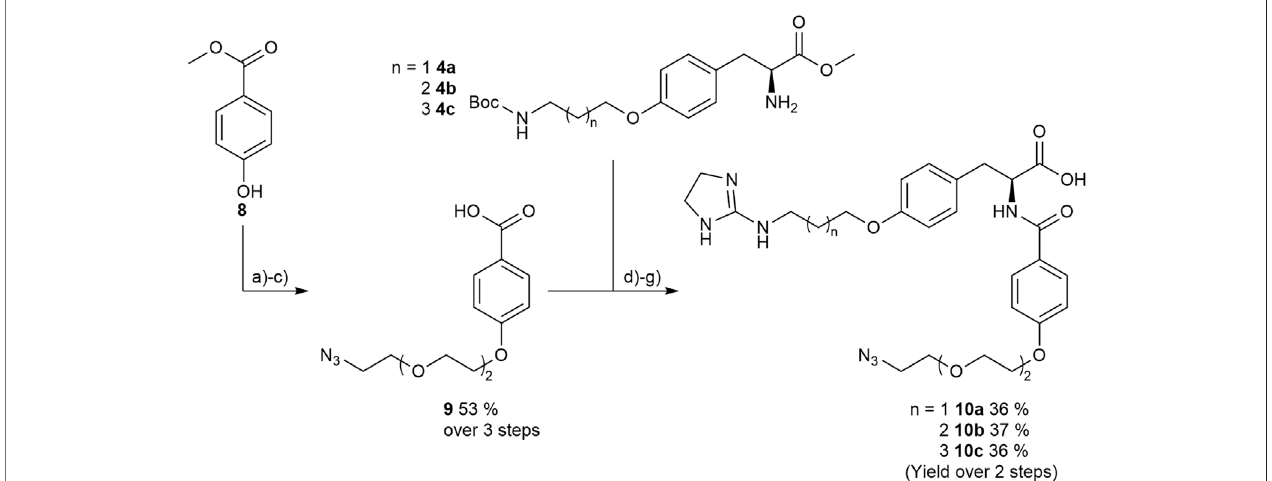
FIGURE 9 | Synthesis of RGD mimetics 10a-c for conjugation. Reagents and conditions: a) 2-(2-(2-chloroethoxy) ethoxy) ethan-1-ol, DIAD, PPh 3 , THF, 0 ° C- > RT, o.n.; b) NaN 3 , water, DMF, 80 ° C- > RT; c) LiOH, water, methanol, THF, o.n. RT; d) HOBt, EDC, DIPEA, DMF, DCM, o.n., RT; e) 4 M HCl in dioxane, DCM, RT; f) 2- methylthio-2-imidazoline, triethylamine, methanol, 80 ° C, o.n.; and g) LiOH, water, methanol, RT.